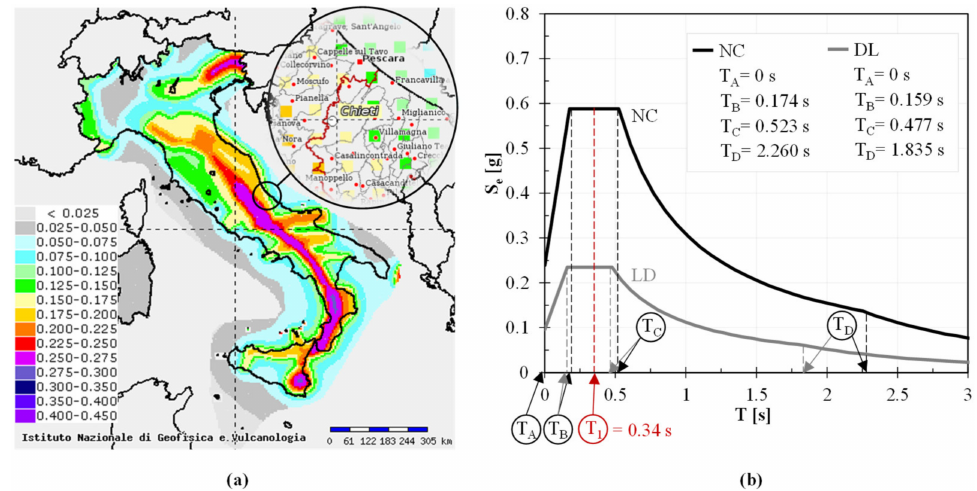
Figure 4. Seismic hazard map of Italy at 10% probability of exceedance in 50 years ( a ); Elastic Response Spectra ( b